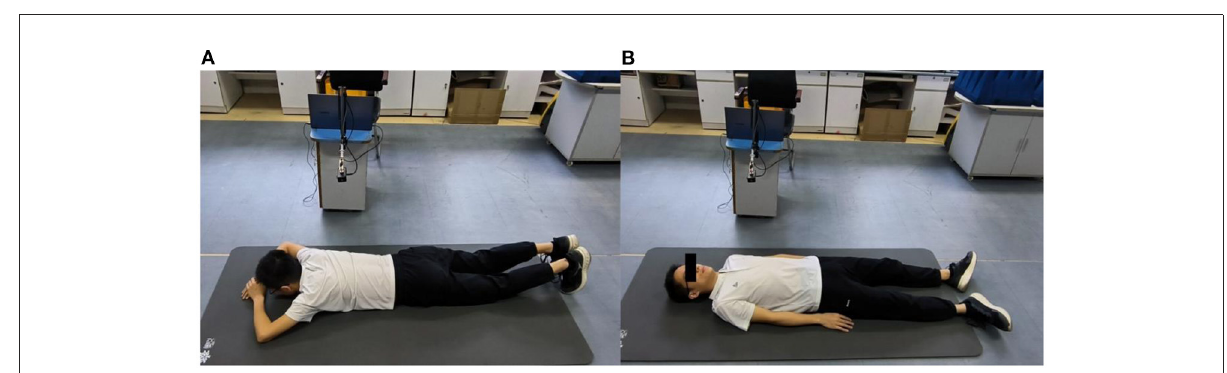
FIGURE9 Anteroposterior measurements, (A) measured from back side, (B) measured from front